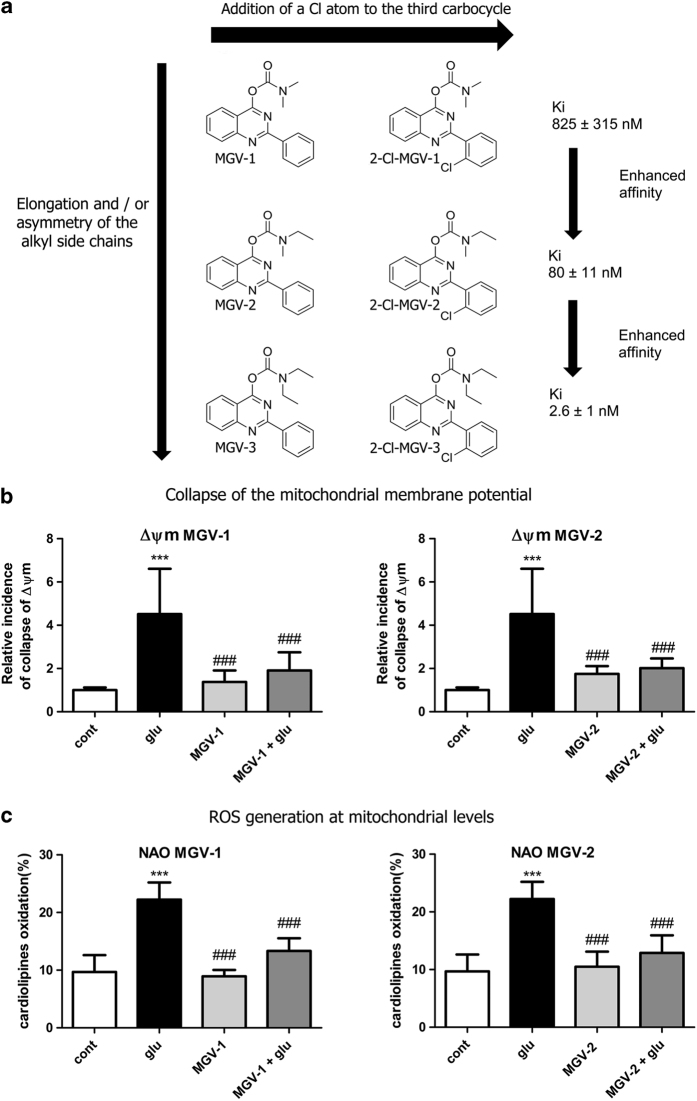
Molecular structures of the tricyclic, quinazoline-based compounds of this study. (a) Stepwise changes in the molecular structure from MGV-1 (to 2-Cl-MGV-1, MGV-2, 2-Cl-MGV-2, MGV-3, and 2-Cl-MGV-3, respectively). Note: the stepwise changes include additions of single C atoms to the methyl side chains, and adding a Cl substituent to the third, rotatable carbocycle. Elongation of the methyl chains to ethyl (symmetric as well as asymmetric) leads to enhanced affinity. Addition of a Cl substituent to the second position in the third rotatable carbocycle does not affect affinity. Affinity is presented as Ki derived from displacement of [3H]PK 11195. (b) These compounds can counteract collapse of the ΔΨm induced by 35 mM of glutamate, for example, by 25 μM of MGV-1 as well as MGV-2, as assayed with JC-1. (c) MGV-1 and MGV-2 (25 μM) also prevent of mitochondrial ROS generation induced by glutamate (35 mM), as assayed by NAO. The results are expressed as mean±S.D. ANOVA followed by the Bonferroni correction for multiple comparisons as post hoc: ***P<0.001 versus control, ###P<0.001 versus glut 35 mM (in b, n=12; in c, n=8).